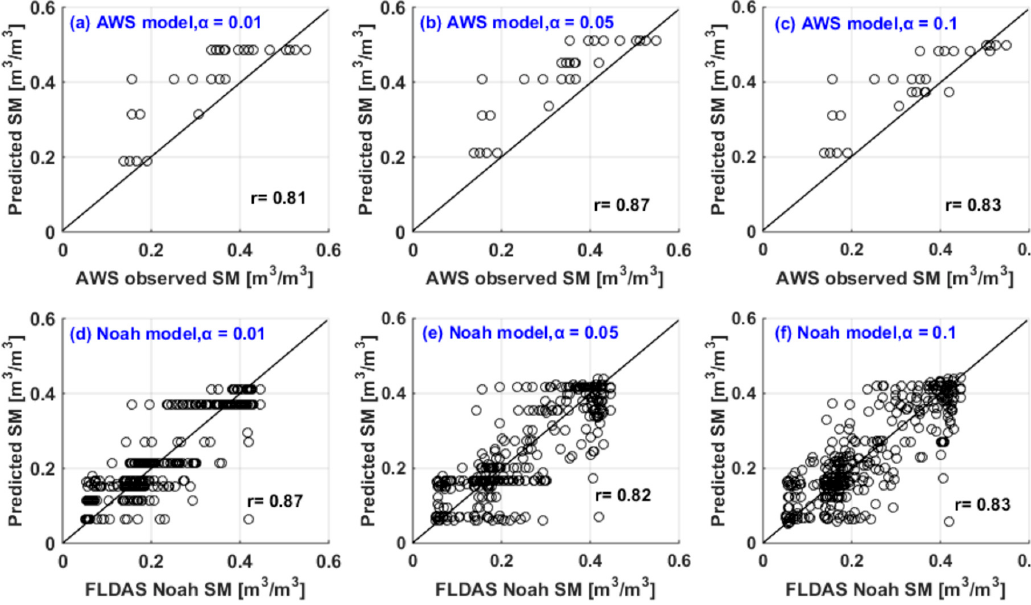
Figure 4. Comparison of the scattering properties of predicted values obtained from different significance levels during the testing periods.